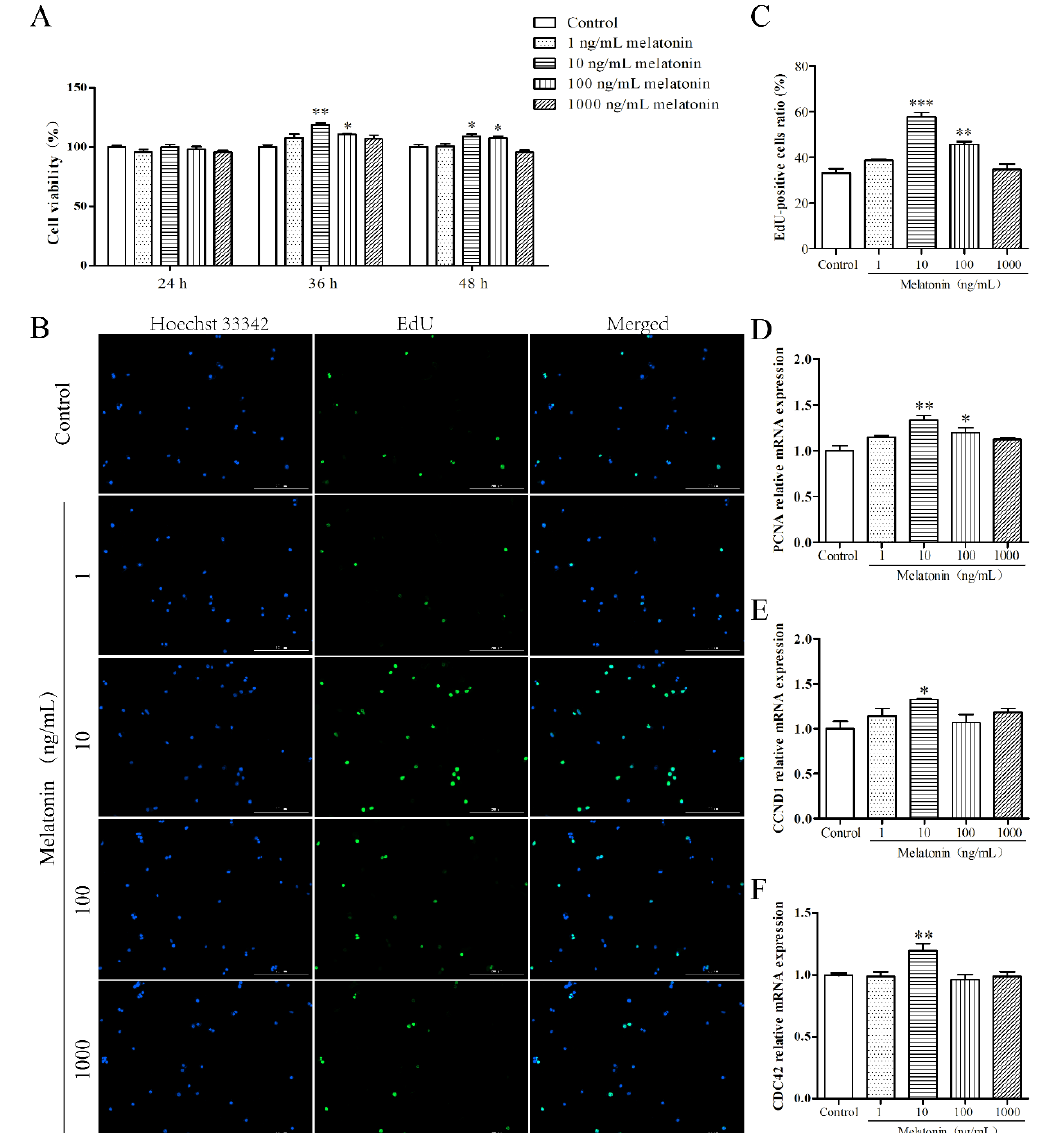
Figure 1. Effects of melatonin on proliferation of mouse Leydig cells. ( A ) The effects of different concentrations (1, 10, 100, and 1000 ng/mL) of melatonin on the cell viability of mouse Leydig cells at various times (24, 48, and 72 h) ( n = 3). ( B ) Proliferation of mouse Leydig cells treated with different concentrations of melatonin was measured using the EdU incorporation assay ( n = 3). Green fluorescence represents EdU-labeled Leydig cells (original magnification ×10). ( C ) The proportion of EdU-positive Leydig cells as shown in panel B. The relative mRNA expression levels of proliferating cell nuclear antigen ( PCNA ) ( D ), cyclin D1 ( CCND1 ) ( E ), and cell division control protein 42 ( CDC42 ) ( F ) ( n = 3). Values are shown as mean ± SEM. *** p < 0.001, ** p < 0.01 or * p < 0.05 compared with the control group.